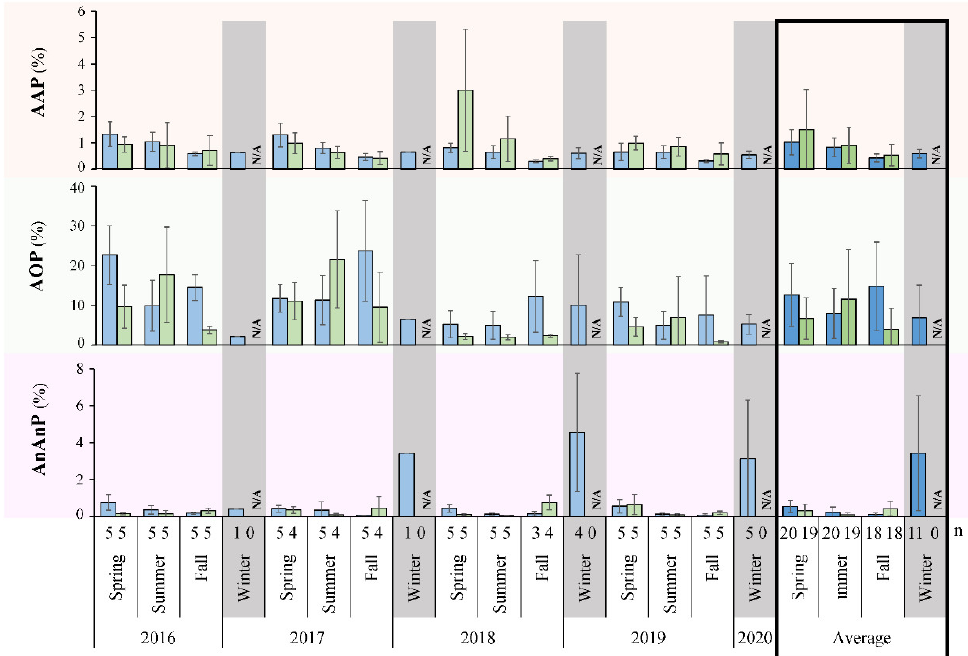
Figure 6. Relative proportions of phototrophs in sequenced communities. All 16S V4 rRNA genes of species and genera representing AAP, AOP, or AnAnP at limnetic (blue) and littoral (green) sites summed for each season. N/A, not analyzed; n, number of samples per season.